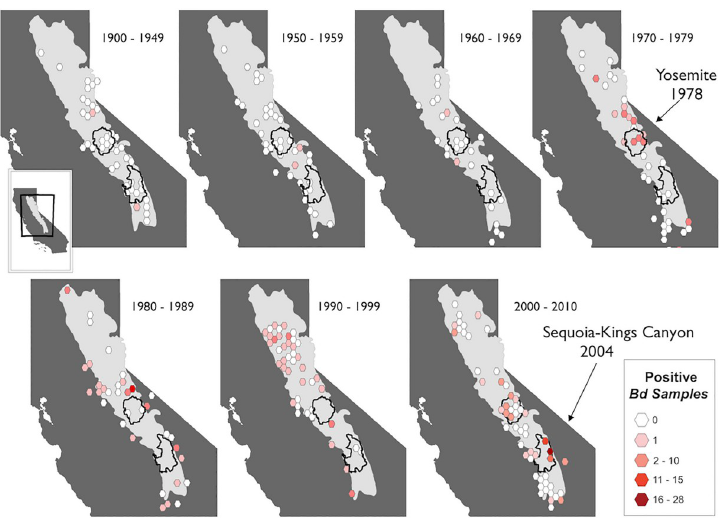
Fig 3. New incidences of Bd -positive amphibians in the Sierra Nevada mountain range per time period in California from 1900–2009. The earliest Bd positives (12/26) were detected in Yosemite National Park were in the 1970s (mass die offs documented there in 1978 [Sherman and Morton 1993]). The first Bd positives (1586/3492) detected in Sequoia- Kings Canyon National Parks were in the 2000s (mass die offs documented there beginning in 2004; [7]). The Sierra Nevada mountains are denoted by light gray shading.